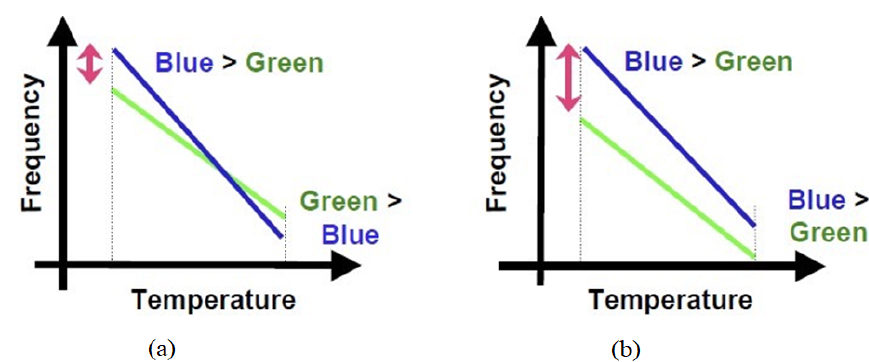
Figure 9. A complete circuit design of the proposed d-ROPUF technique for an FPGA area (120